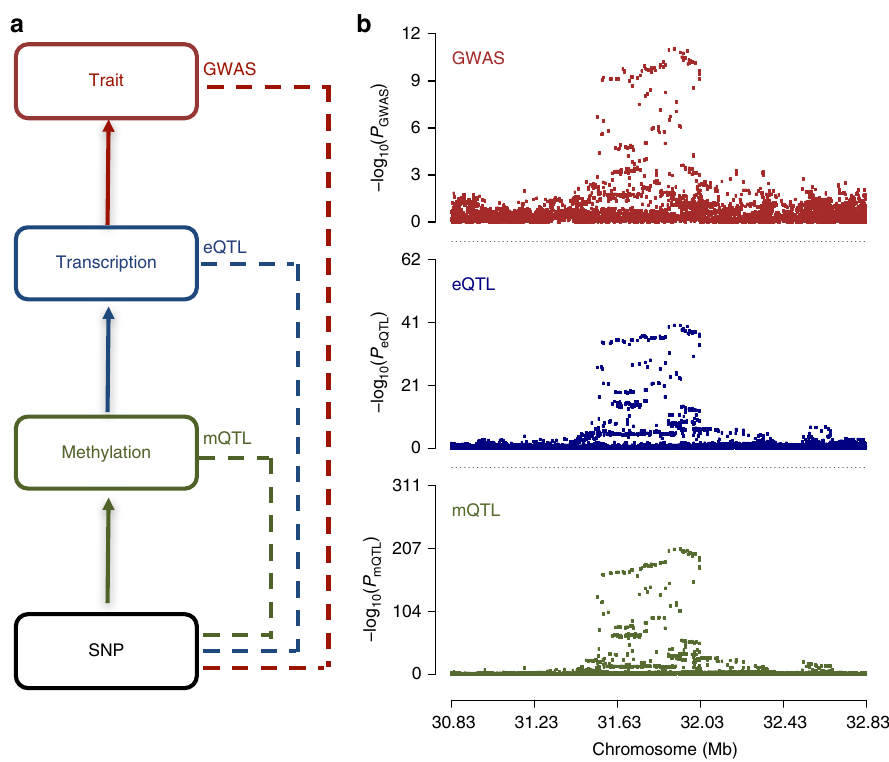
Fig. 1 Schematic of our integrative analysis of multi-omics data. a A hypothetical model of a mediation mechanism tested in our analysis: an SNP exerts an effect on the trait by altering the DNAm level, which regulates the expression levels of a functional gene. b An example by simulation under our hypothetical model (Supplementary Note 1), in which the observed SNP-association signals are consistent at the shared GWAS locus across methylation, transcript and trait phenotype (see Fig. 7b for a real data